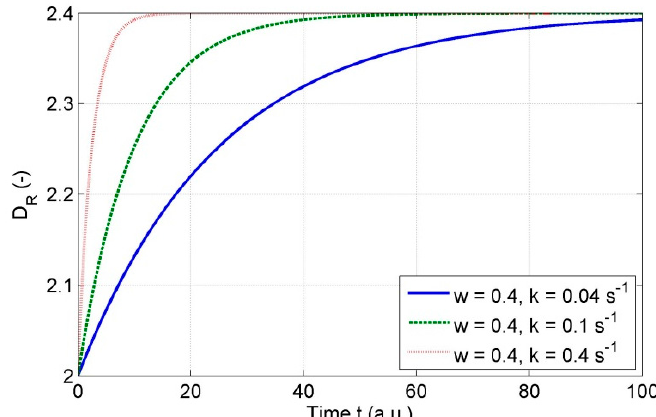
Figure 4. Simulation of hypothetic time-dependence of D R on the time in the case of adsorption processes—influence of diffusion of adsorbate on fractal surface topography.